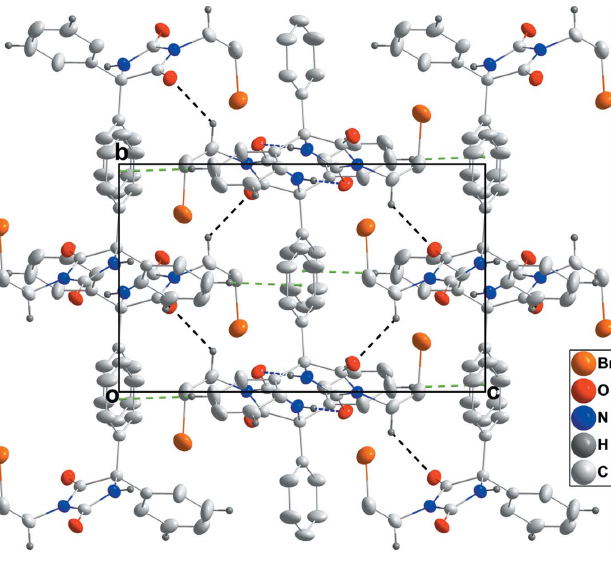
Figure 3 Packing viewed along the a- axis direction with intermolecular inter- actions depicted as in Fig. 2.